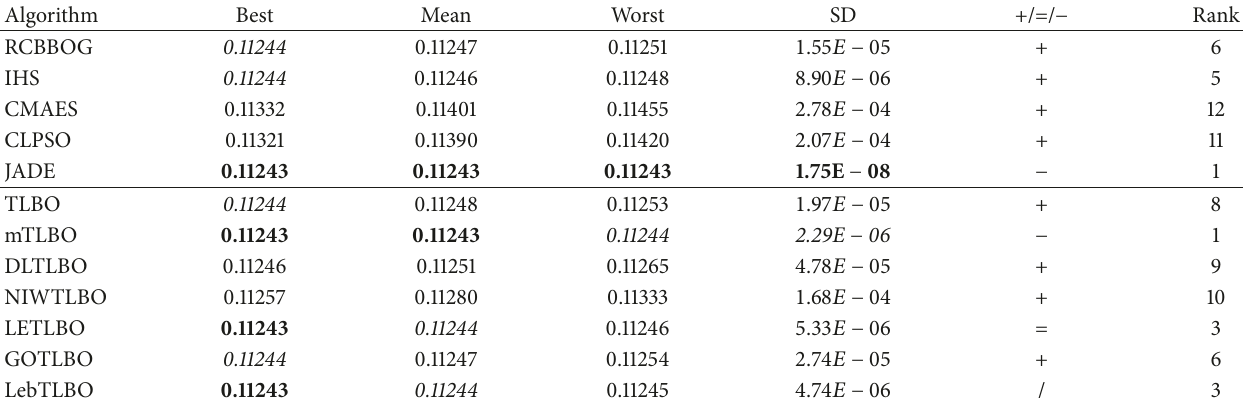
Table 10: Simulation results on the six-plate gas absorption tower problem.